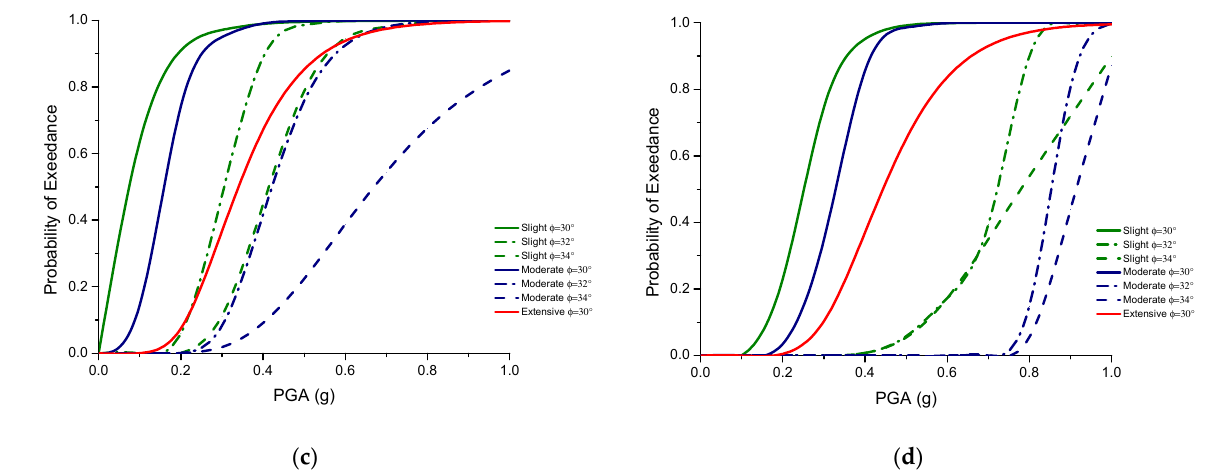
Figure 6. Fragility curves of the embankments due to friction angle variation, ( a ) E1, near-field, c = 32.5 kPa ( b ) E3, near-field, c = 0 kPa ( c ), E1, far-field, c = 32.5 kPa ( d ) E3, far-field, c = 0 kPa. Table 7. Fragility curve parameters considering several friction angles of the soil properties sub- jected to near-field and far-field earthquake ground motions.